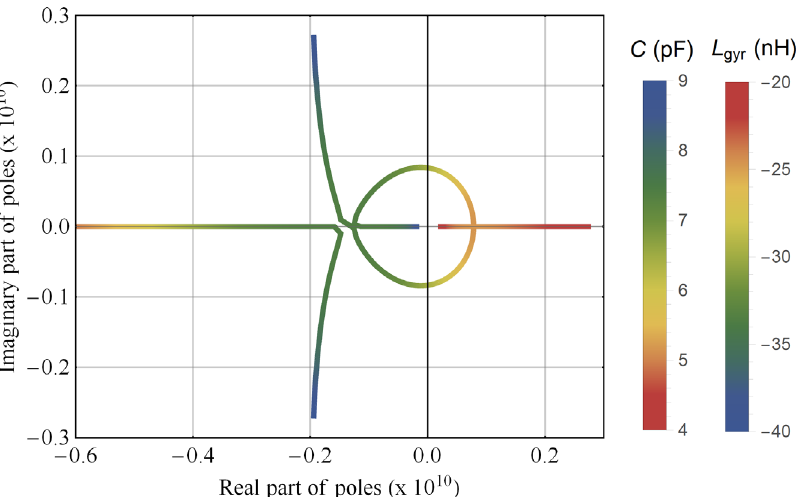
Fig. 14. Poles loci at node A ( g m = 15mS, C varies from 9pF to 4pF when L gyr goes from (cid:2) 40nH to (cid:2) 20 nH).